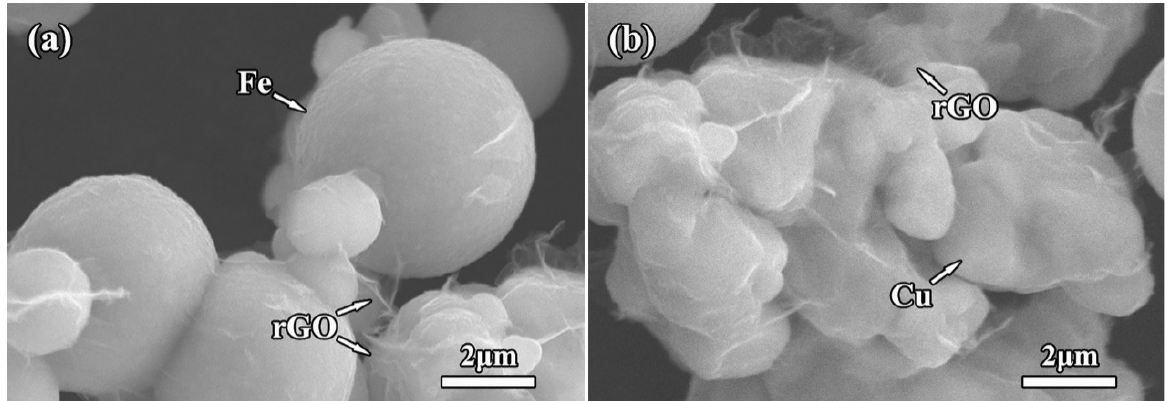
Figure 4. High-magnification SEM micrographs showing the rGO nanosheets coated on the surface of Fe microspheres ( a ) and Cu particles ( b ) in the mixture powders.